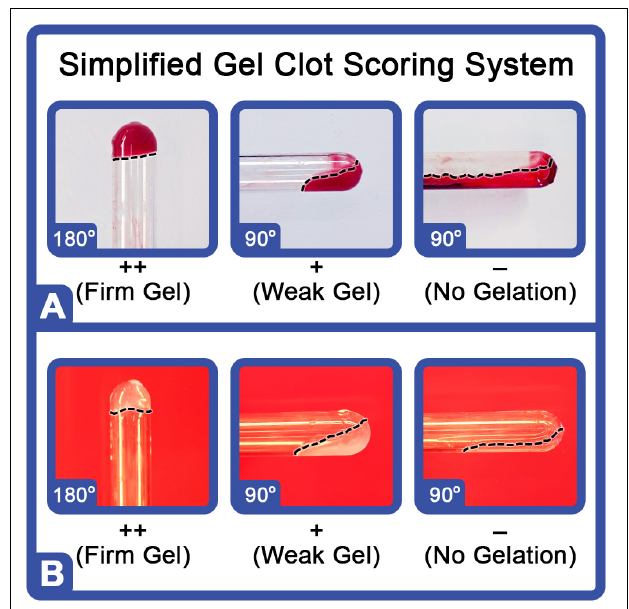
FIGURE 8 | Visual scoring of gelation of LAL in the presence of LPS or bacteria. Representative results of LAL in the presence of LPS or bacteria in (A) human blood or (B) a standard control (endotoxin-free water). The gel clot detection range of 0.05–50.0 EU/ml was used in the test. Clot ratings: firm, opaque gel remaining stable after 180 ◦ inversion (++); soft gel with moderate to considerate opacity and tube adhesion when rotated 90 ◦ (+); weak gel with slight-to-moderate opacity and adhesion of starch-like floccules to sides of the tube when slanted ( ± ); and no visible increase in viscosity or opacity (–) (Bishop and White, 1986).